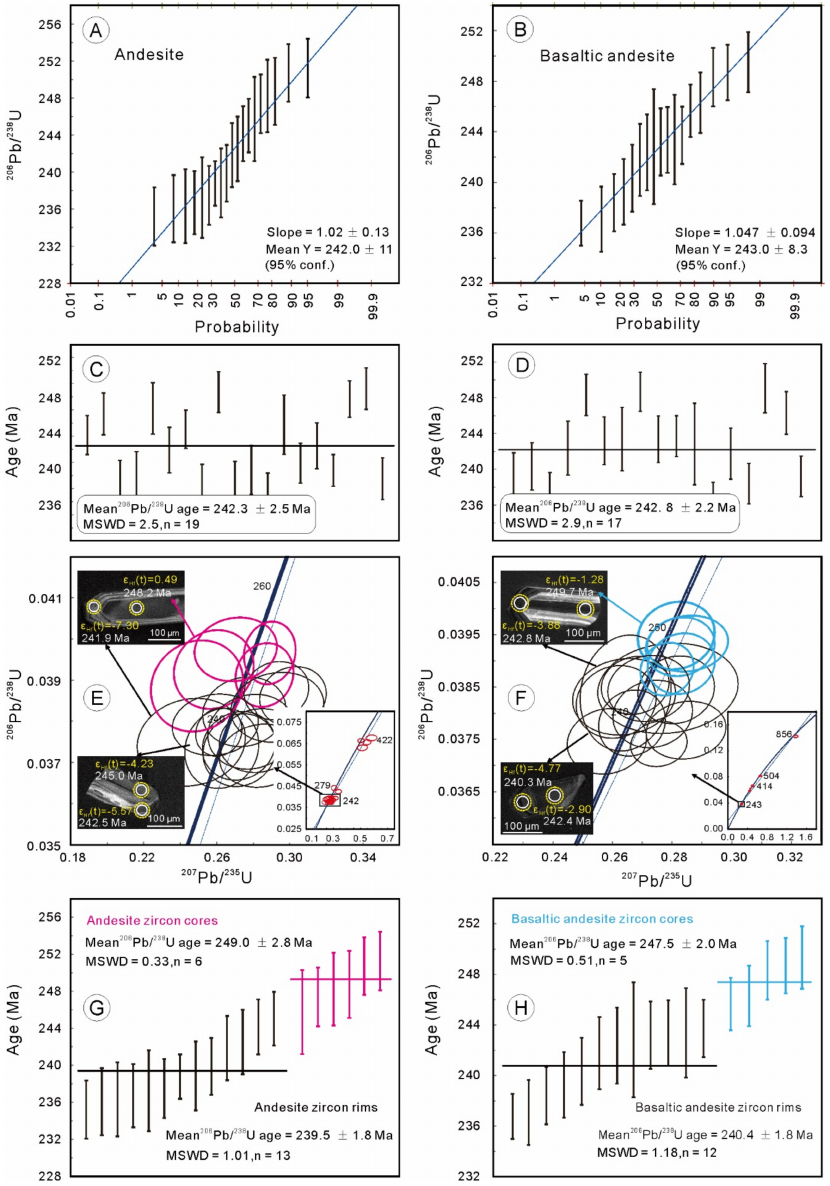
Figure 3. ( A , B ) Linearized probability density plots and ( C , D ) weighted mean zircon ages of the Nageng andesite and basaltic andesite samples; ( E , F ) Zircon U-Pb concordia diagrams and represen- tative zircon cathodoluminescence (CL)-images from andesite and basaltic andesite; ( G,H ) Weighted mean ages of zircon rims and cores from andesite and basaltic